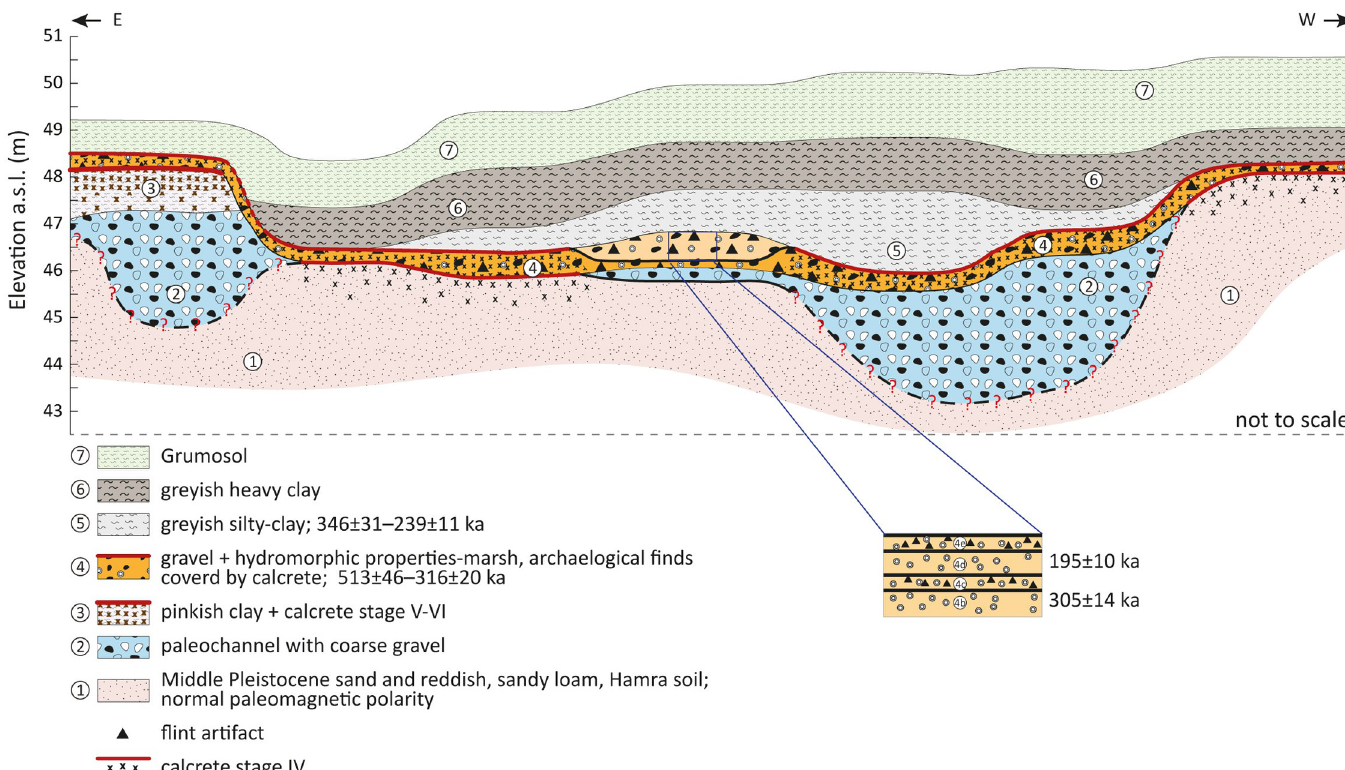
Fig 15. Composite schematic reconstruction of the depositional history at the site of